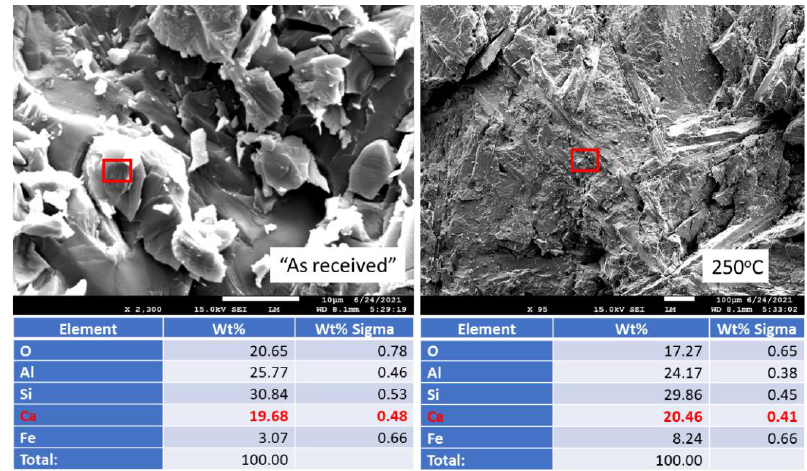
Figure 18. Photomicrographs of mullite samples with the elemental composition of typical sites shown by the red boxes.